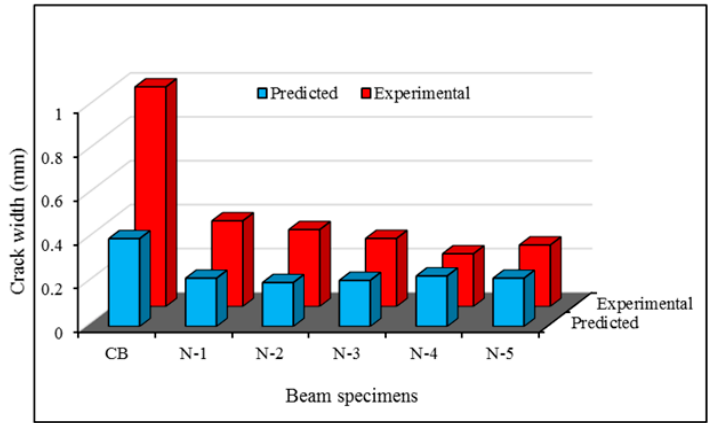
Figure 17. Comparison of experimental and predicted crack width.